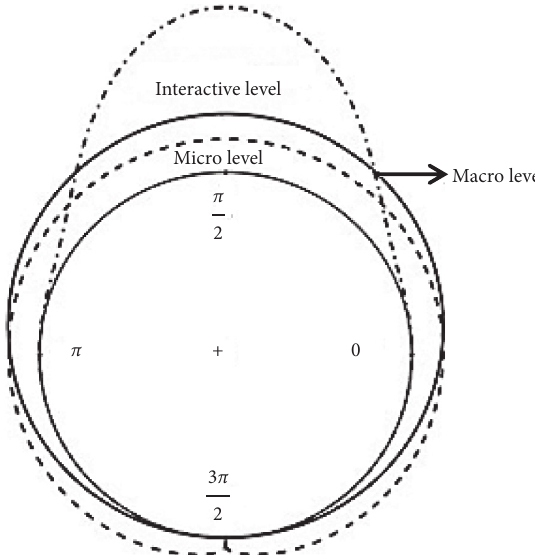
Figure 1: The classification of indicator levels using cosine power